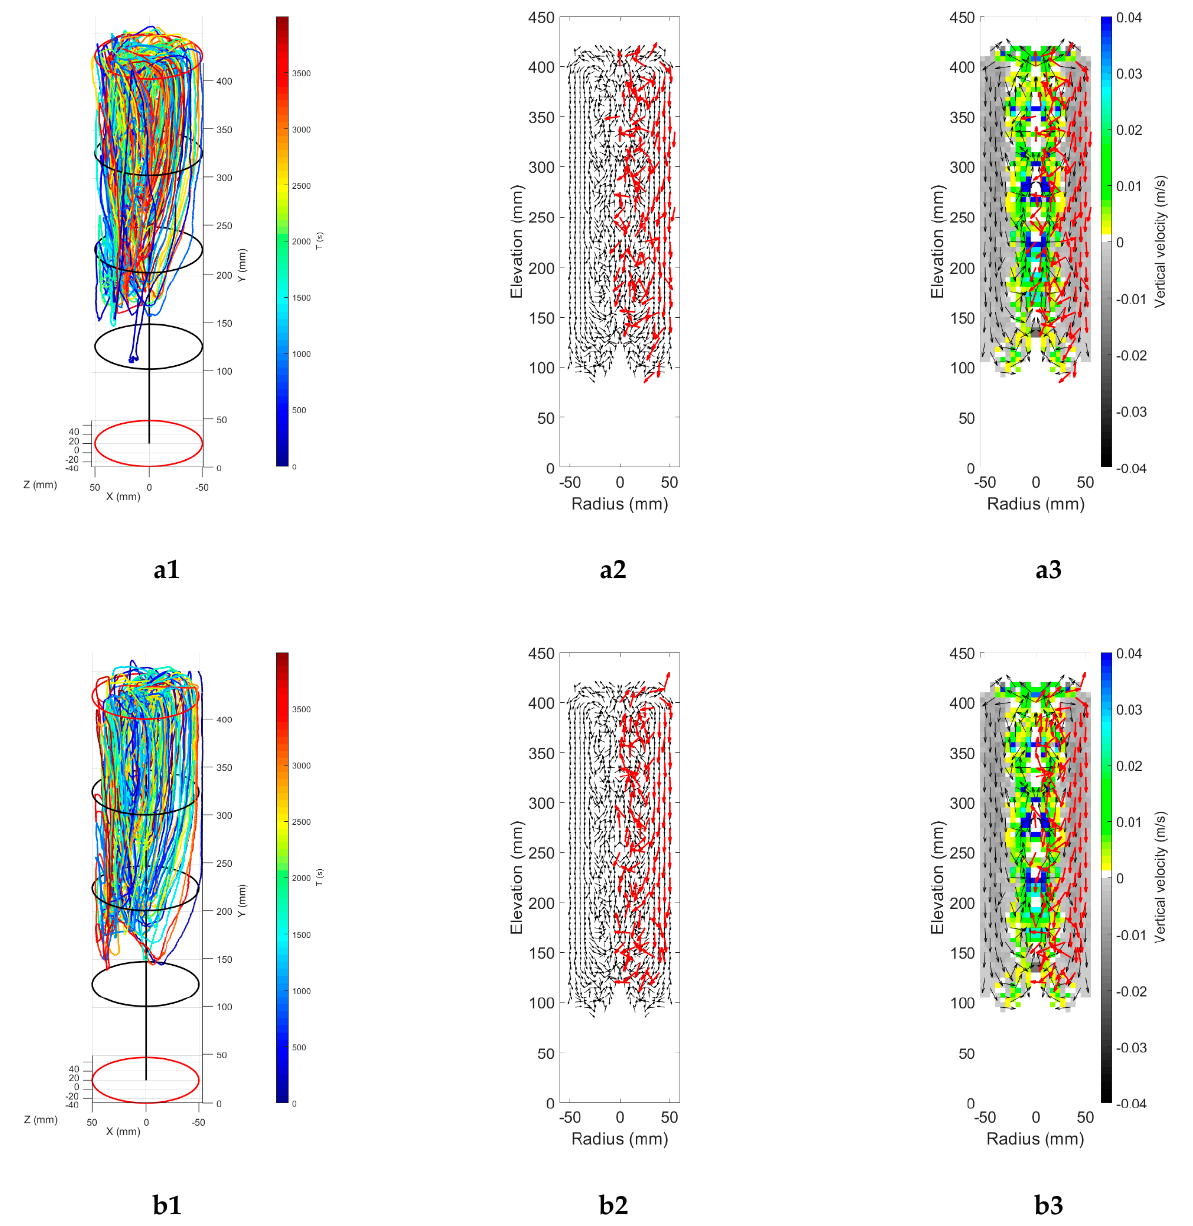
Figure 6. The results of 2 runs ( a , b ) of a − 212 + 150 µm hematite particle for an airflow rate of 1.50 u mf (Lagrangian trajectory (1) and Eulerian flow maps (2 and 3)). Even though there was no observable separation, the results indicate that mixing the light (quartz) and heavy (hematite) material in this size fraction can be useful for creating denser beds.